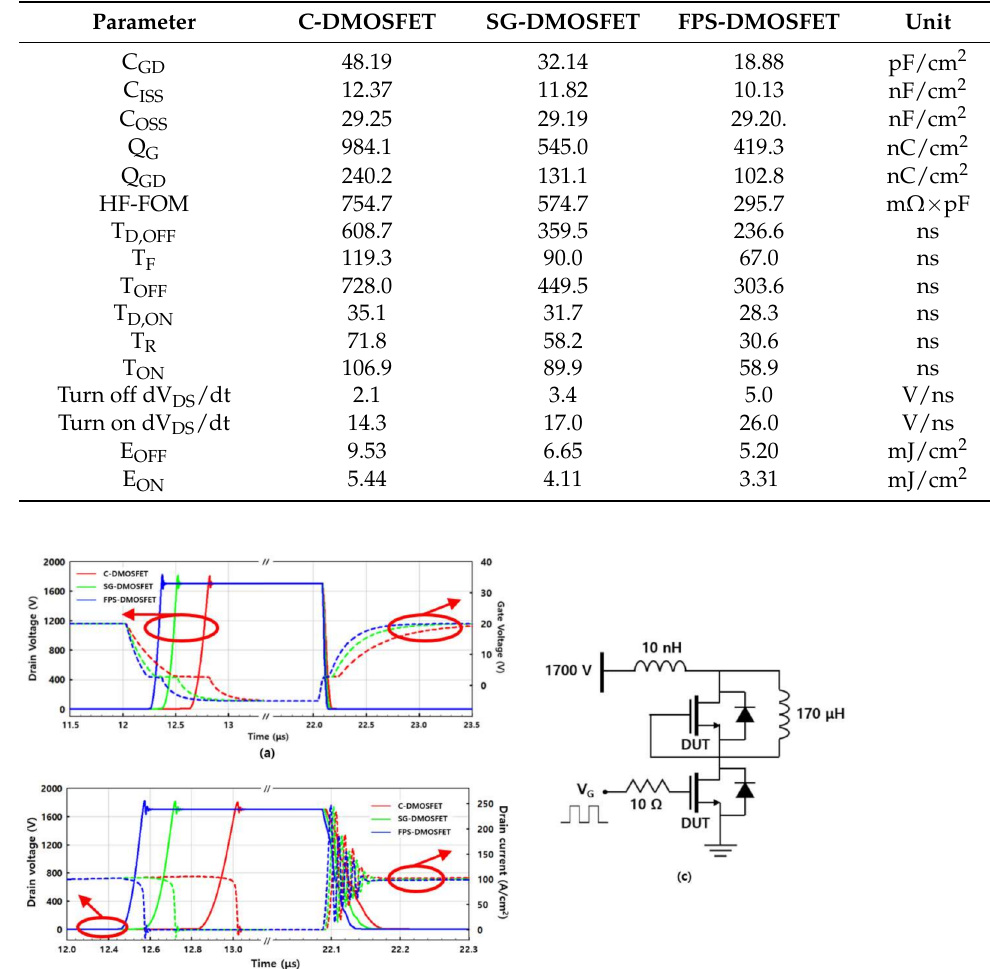
Table 3. Dynamic characteristics of three structures.